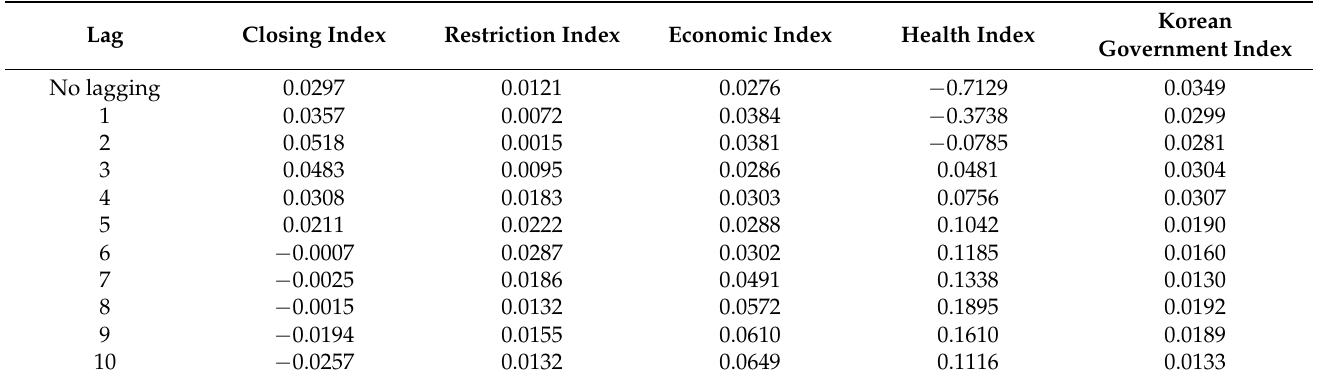
Table 6. Non-Seoul Metropolitan Area’s Coefficients from Multiple Indices Model.